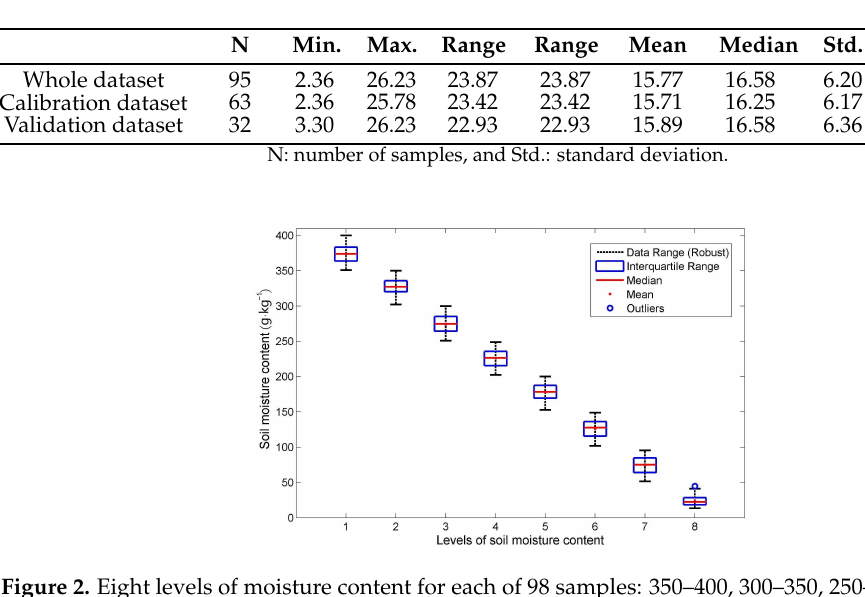
Table 1. Statistical descriptions of Soil Organic Carbon (SOC) content (g · kg − 1 ) of 95 soil samples.